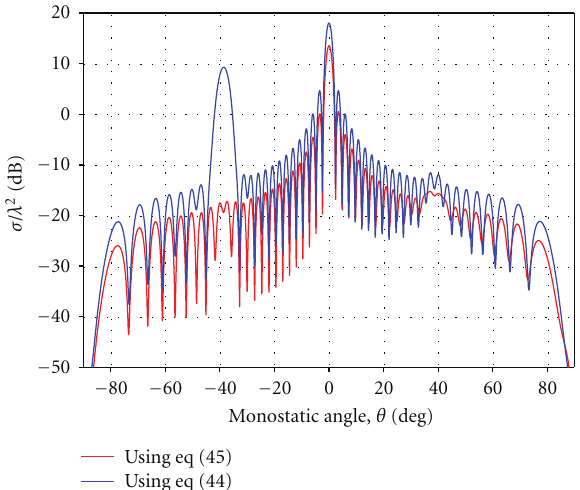
Figure 15: RCS of series-fed linear array. N = 30, θ s = 0 ◦ , ψ = π/ 2, d = 0 . 4 λ , l = 0 . 5 λ , and r amplitude distribution.